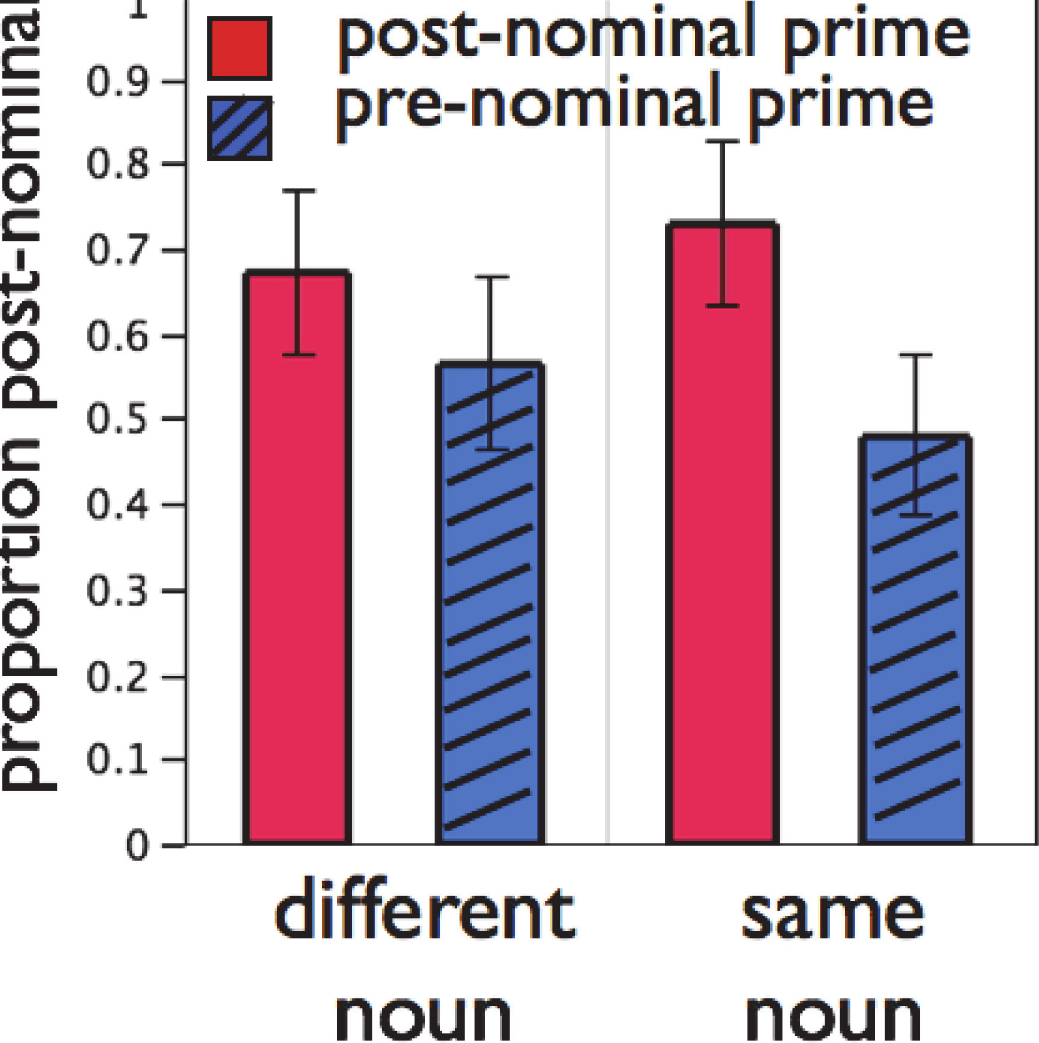
Fig 2. Syntactic priming with lexical boost in hearing L2 signers. Hearing L2 signers used post-nominal descriptions more after post-nominal primes (plain bars) than after pre-nominal primes (hashed bars), especially when the noun was repeated from prime to target. Error bars represent